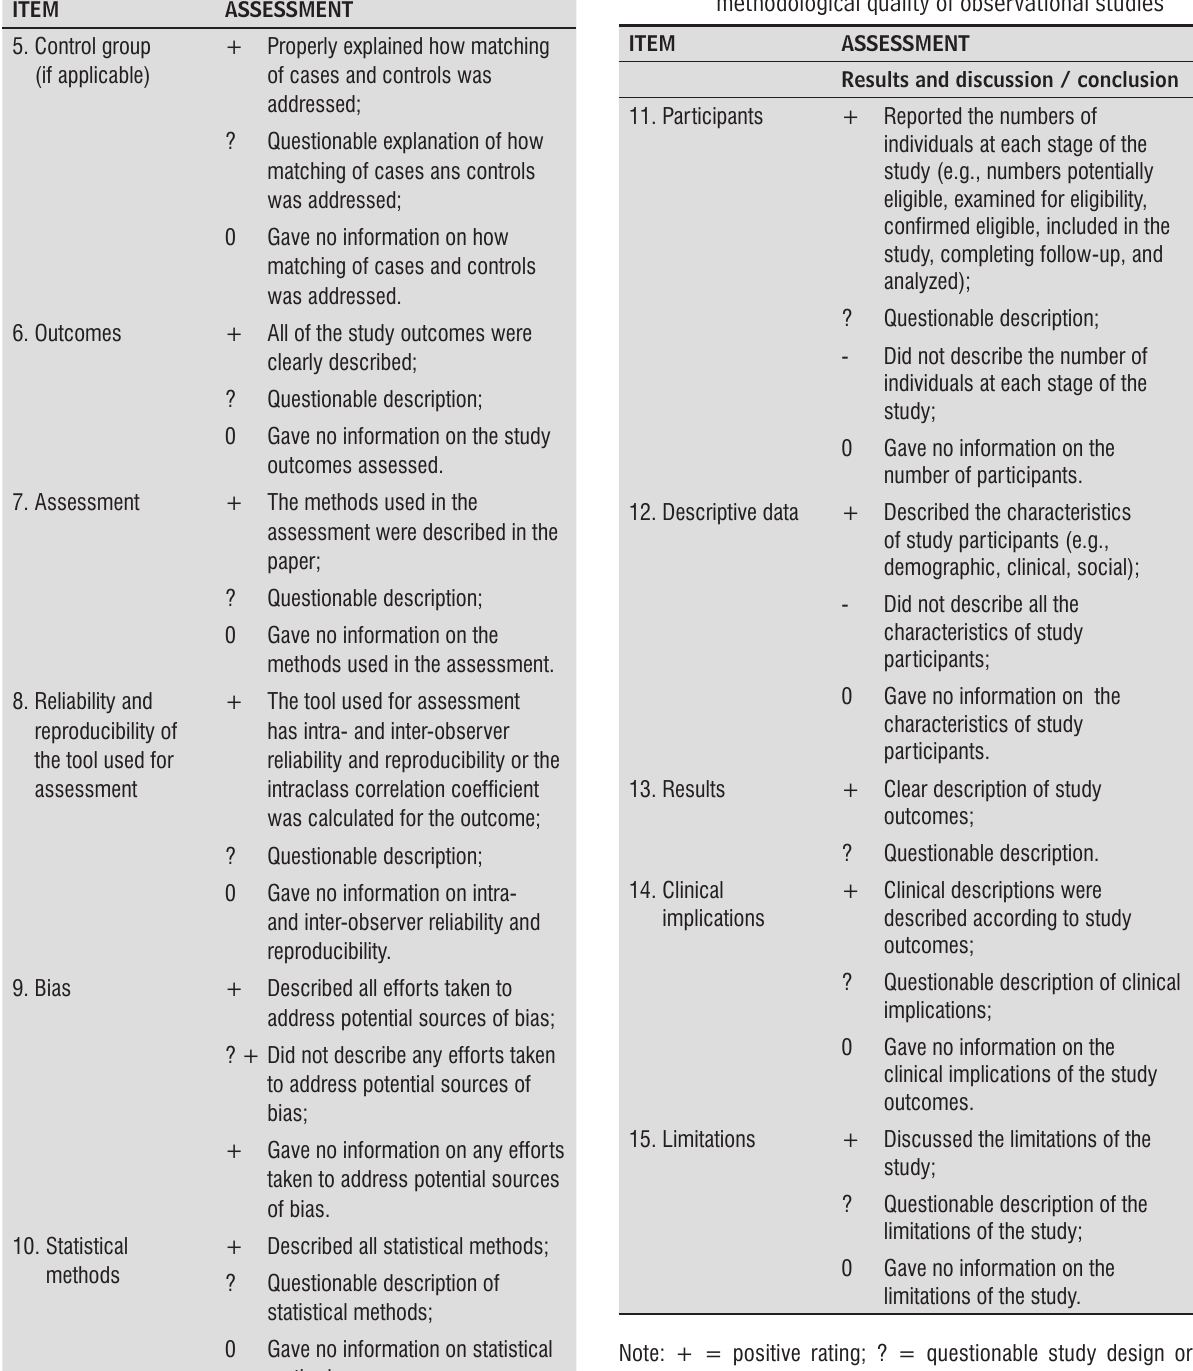
Table 1 - The STROBE checklist for assessment of methodological quality of observational studies